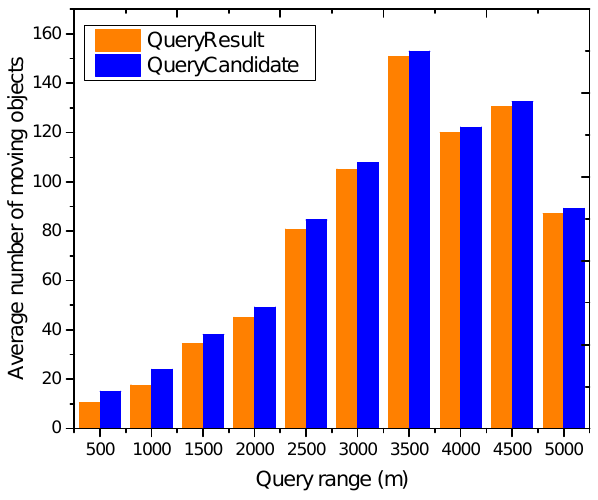
Figure 9. The average number of moving objects obtained in query results and the query